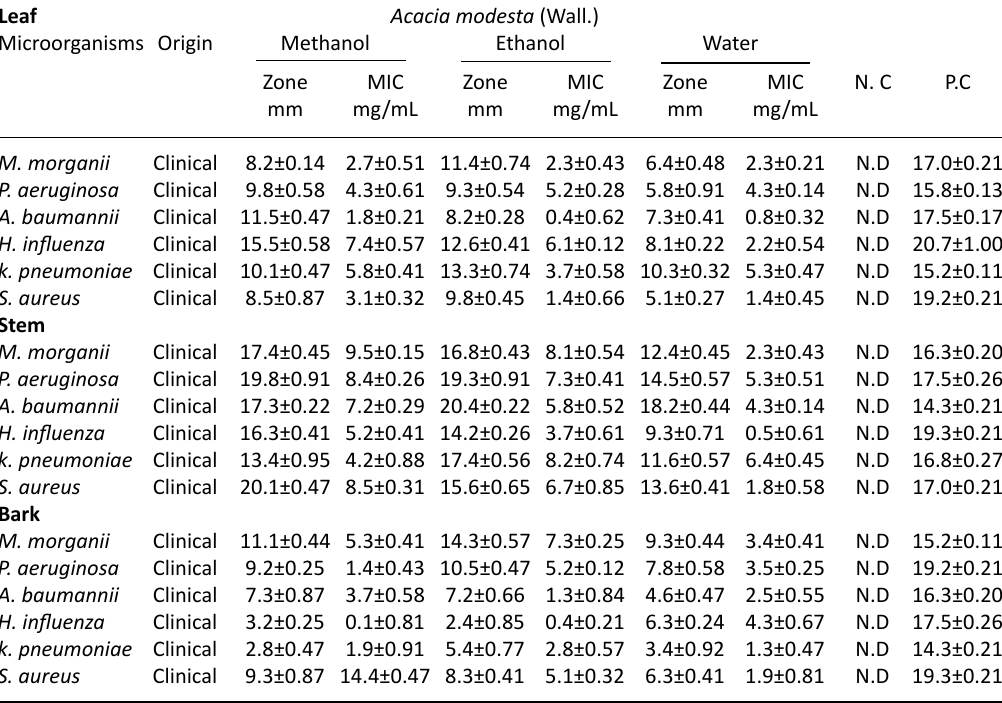
Table 3. Antibacterial activity of Acacia modesta (Wall.) extracts against bacterial pathogens Leaf Acacia modesta